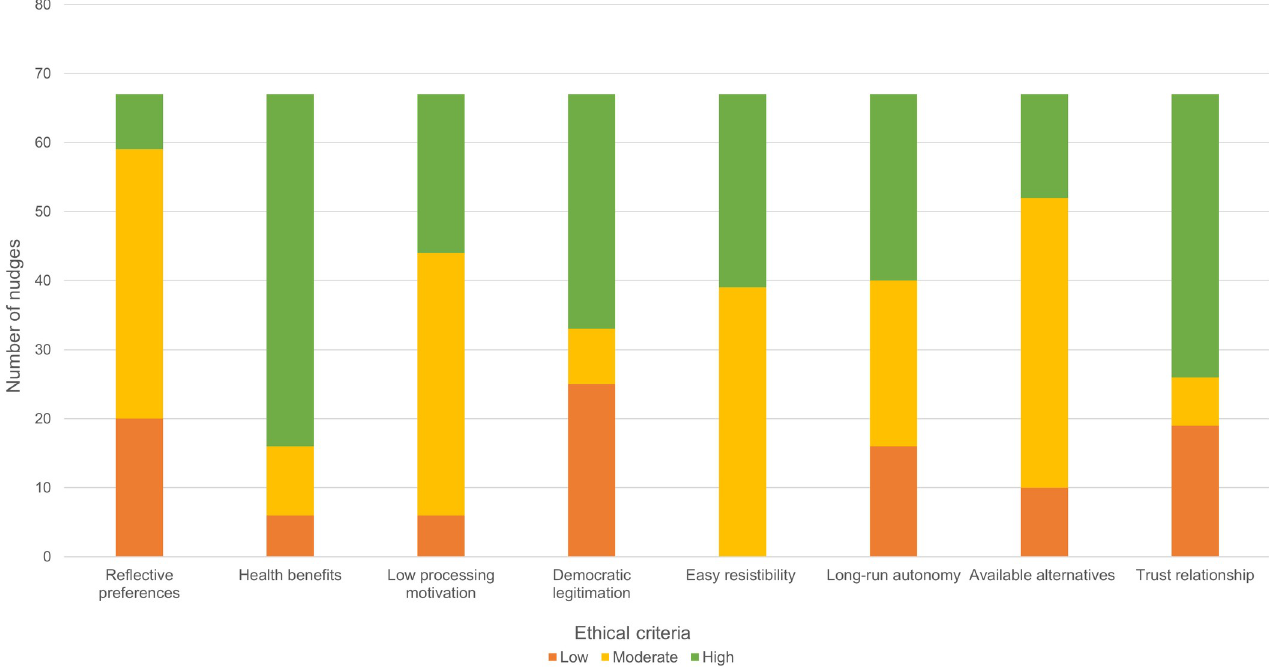
Fig 4. Ethical assessment of 67 nudge strategies targeting health promotion behaviors related to neglected tropical diseases in low- and middle-income countries. Nudge strategies were assessed according to eight criteria: Reflective preferences (RP); Health benefits (HB); Low processing motivation (LP); Democratic legitimation (DL); Easy resistibility (ER); Long-run autonomy (LA); Available alternatives (AA); Trust relationship (TR), and coded into high (H), moderate (M), and low (L) ethical standard.